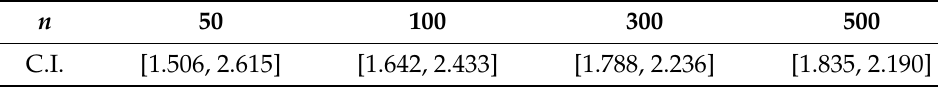
Figure 1. Wilks’ statistic for case 1 ( left ) and case 2 ( right ). Table 2. The 95% confidence intervals for α 0 in case